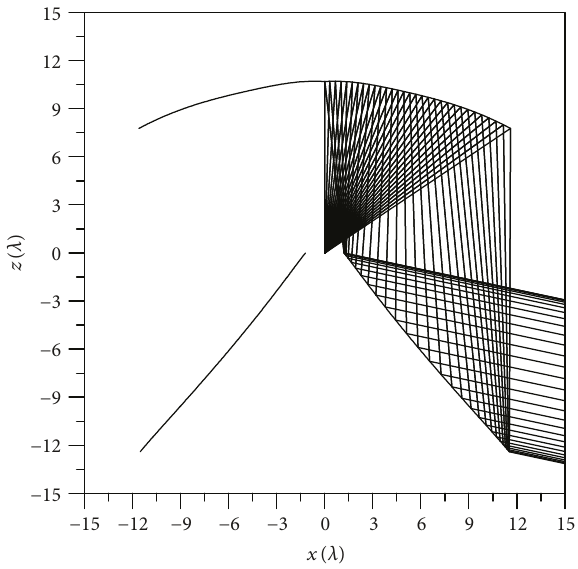
Figure 11: MoM/MMT radiation patterns of the classical and shaped ADC antennas.